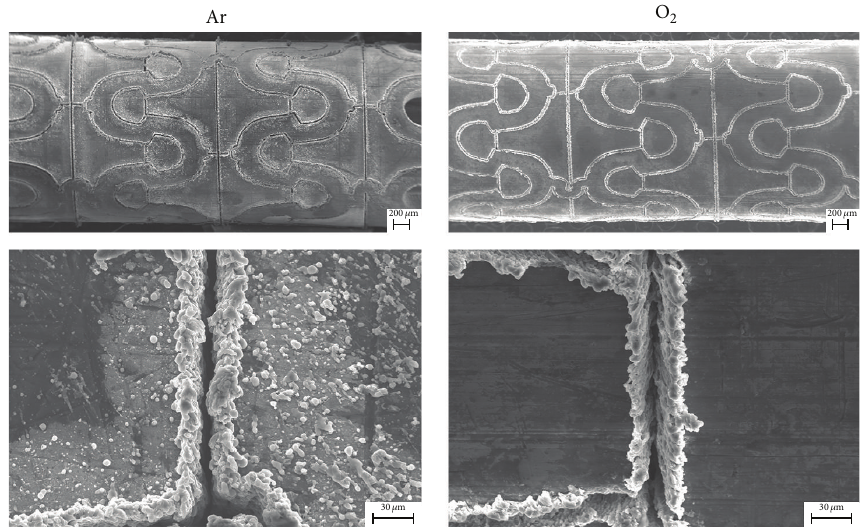
Figure 5: SEM images of the laser microcut stents produced using Ar and O 2 .